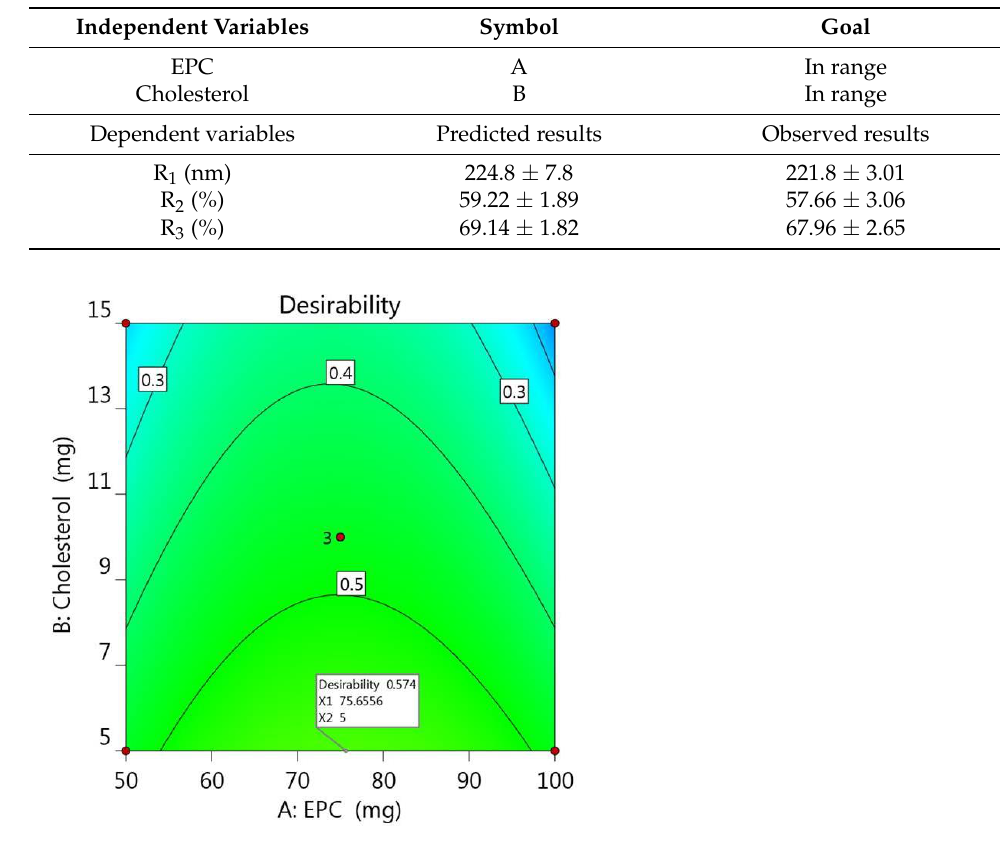
Figure 5. Desirability graph presenting the influence of independent variables A and B on the overall dependent variables R 1 , R 2 and R 3 .